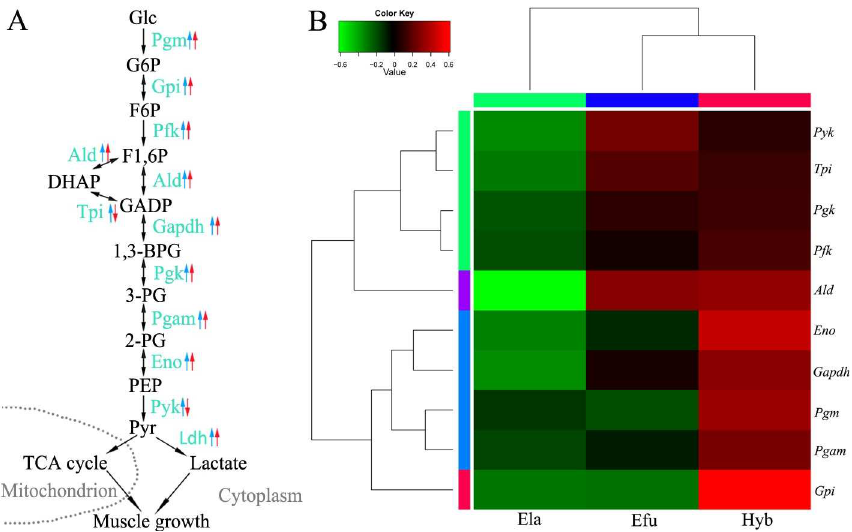
Fig 2. Most glycolysis genes were up-regulated in the hybrid grouper. (A) Diagramrepresentingthe 10 steps of glycolysis. Blue arrows denote the expressiondifferences betweenthe Hyb and paternal Ela. Red arrows denote the expressiondifferences betweenthe Hyb and maternal Efu. Up and down arrows stand for up- and down-regulationof transcription, respectively,in the Hyb; (B) Hierarchical cluster analysisof glycolytic genes. The color key representsRPKM